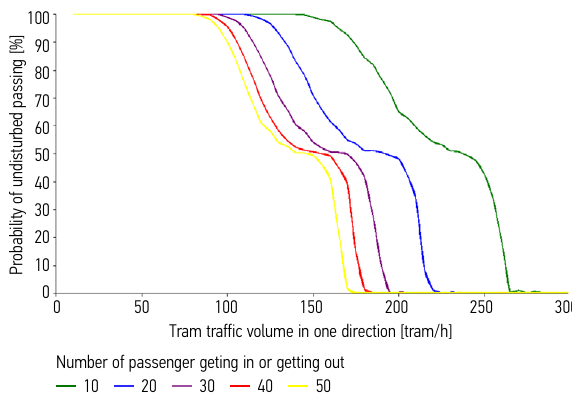
Fig. 5. Probability of undisturbed passing before twin